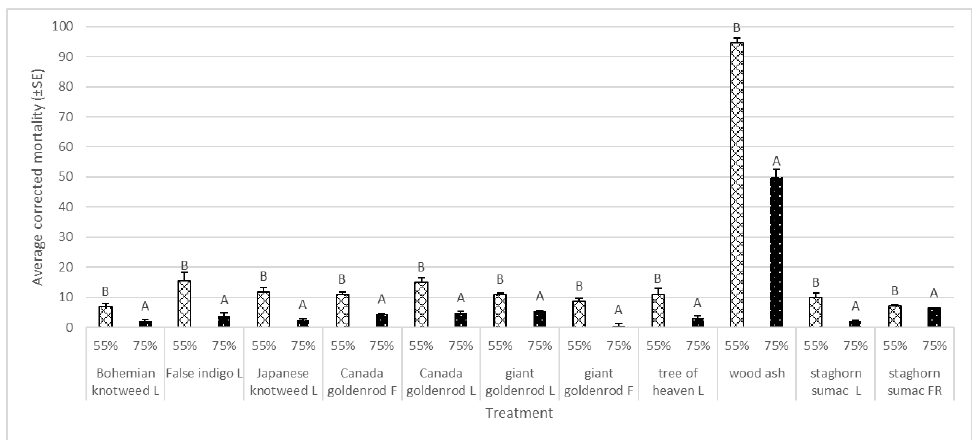
Figure 1. Average corrected mortality for different treatments (uppercase letters present differences within treatments between the R.h. parameter).